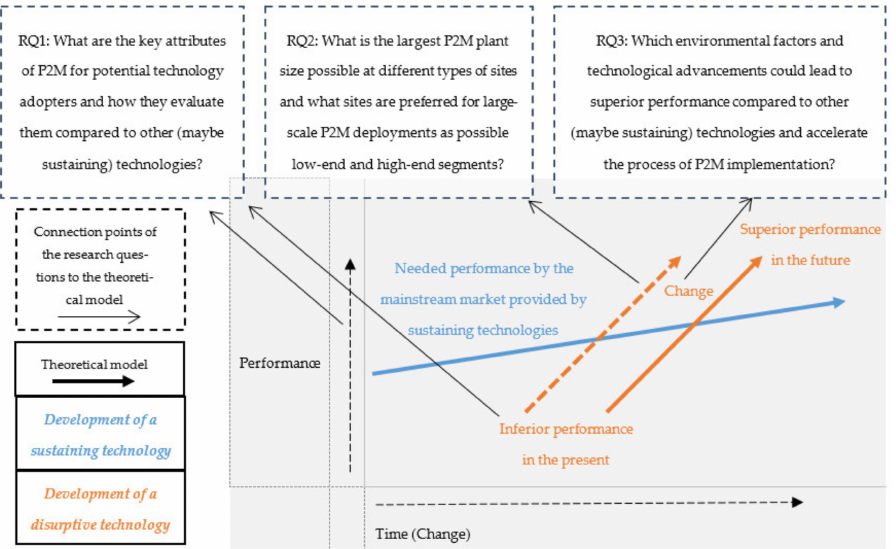
Figure 1. Research framework based on Bower and Christensen’s original model [36]. Research